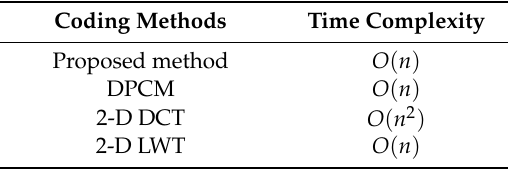
Table 3. Time complexity of di ff erent